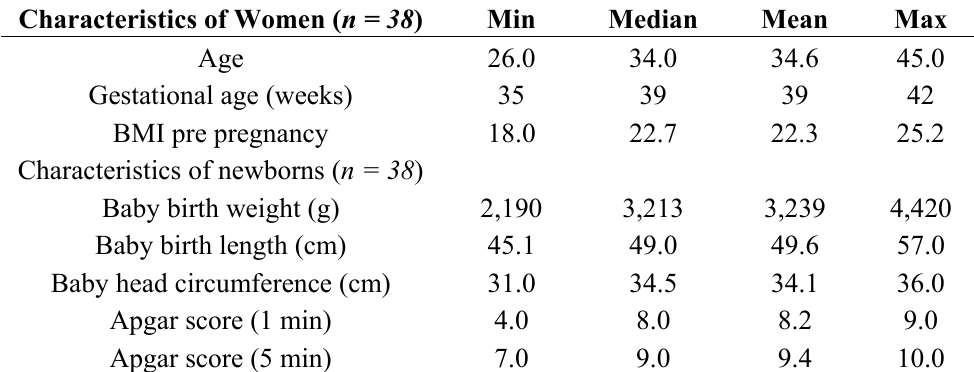
Table 1. General characteristics of the enrolled women and their newborns. Characteristics of Women ( n = 38 ) Min Median Gestational age (weeks) Characteristics of newborns ( n = 38 ) Baby birth weight